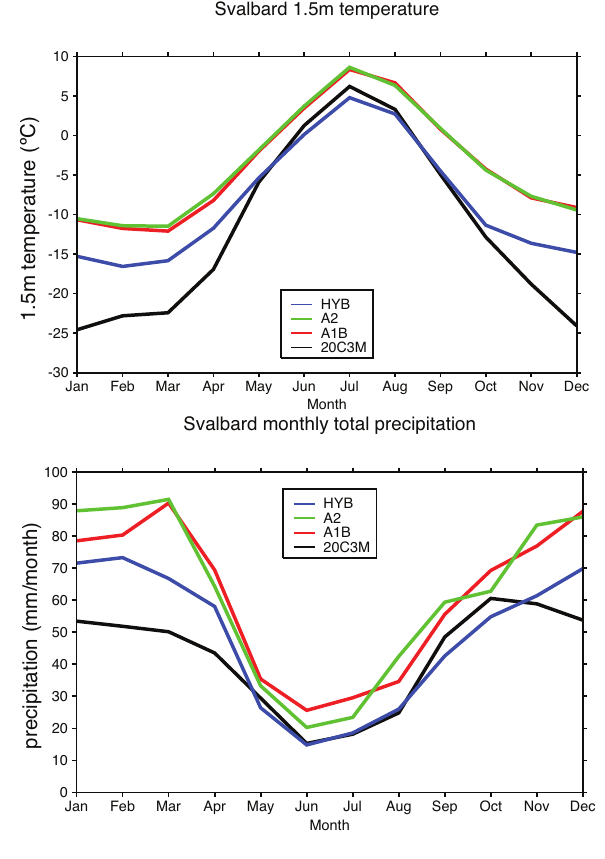
Fig. 9. Svalbard’s monthly mean (area averaged) cycle of surface air temperature ( ◦ C), (a) , and total precipitation (mm/month), (b)